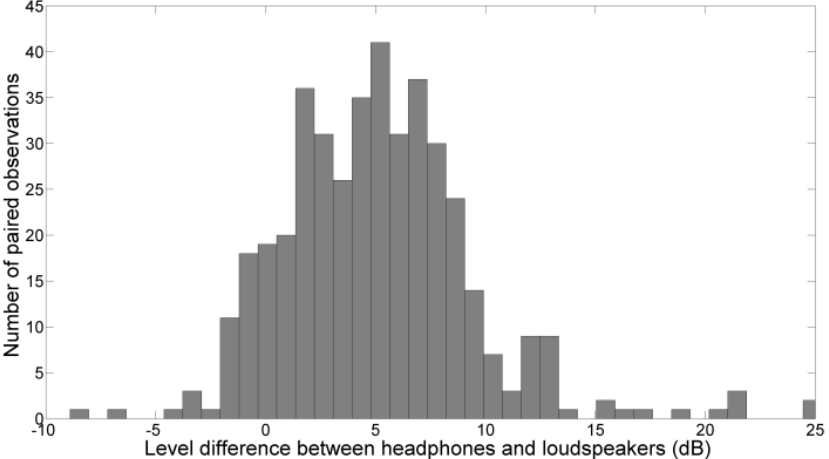
Figure 2. The histogram of the difference of the set A-weighted level of speech listened over head- phones and phones and loudspeakers.